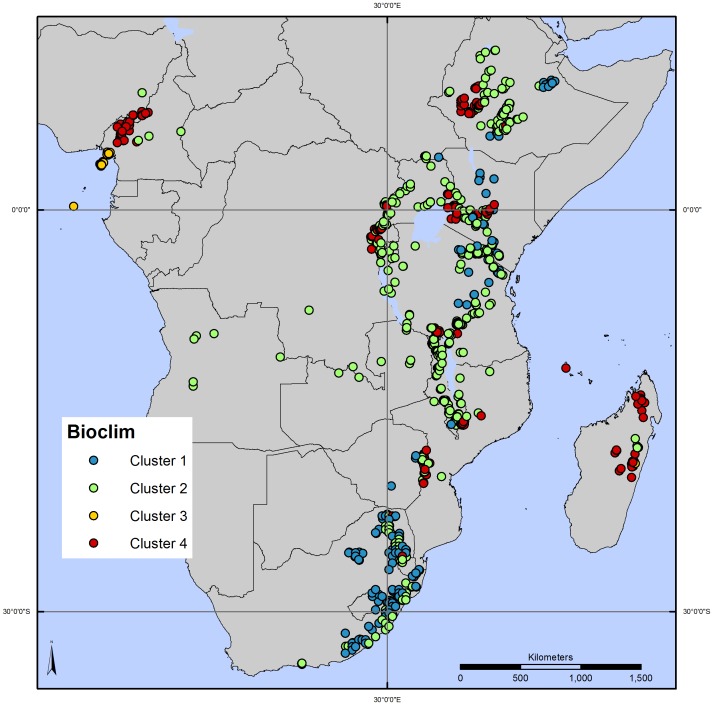
Clustering of 1,500 Prunus africana observations based on level of similarity of bioclimatic variables.Bioclimatic values for 19 variables were associated with all P. africana records. Bioclimatic values were extracted from 2.5 minute rasters obtained from the Worldclim website. The observation points are grouped (each cluster is highlighted with a different colour) by Euclidean distance.